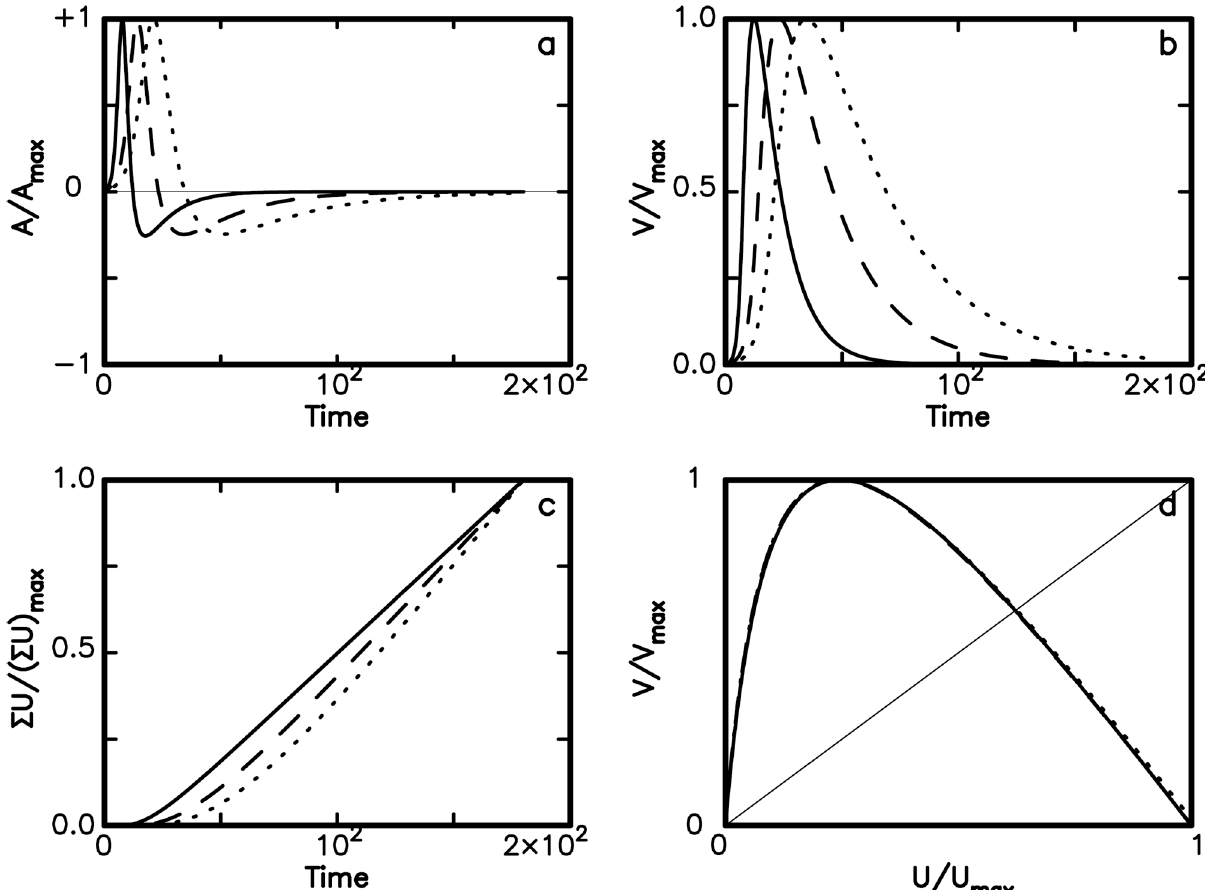
), normalized velocity ( V / V max versus U / U of the slider, acted by TP friction of F ( U )= exp(− U / U max max = c